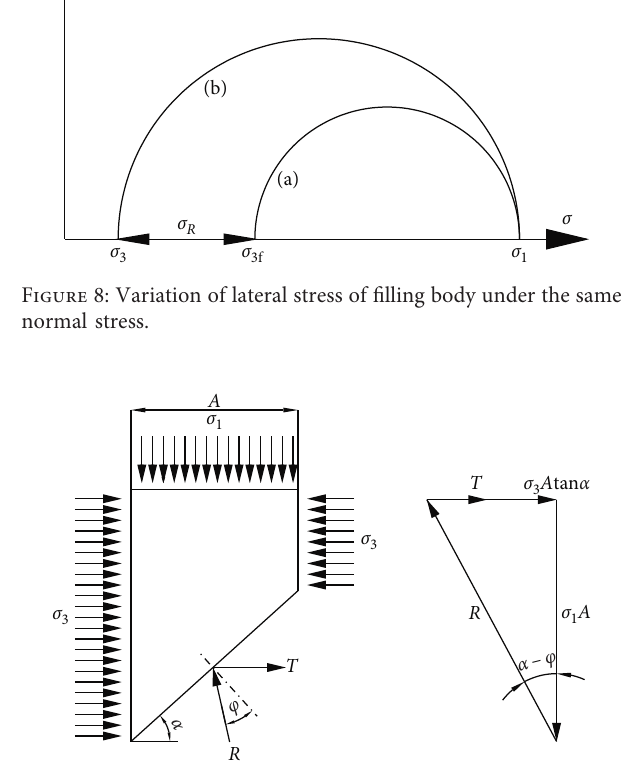
Figure 9: Mechanical balance diagram of reinforced